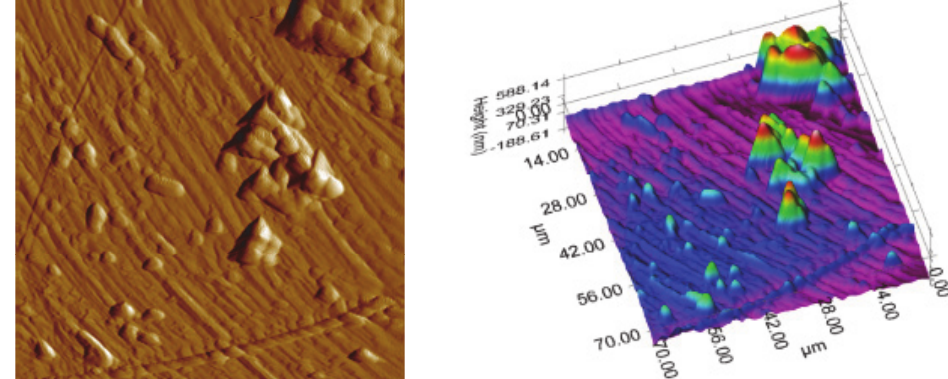
Figure 7: SPM images of different areas of MWCNT/PP 2 wt% specimen (area of 70  70 μ m 2